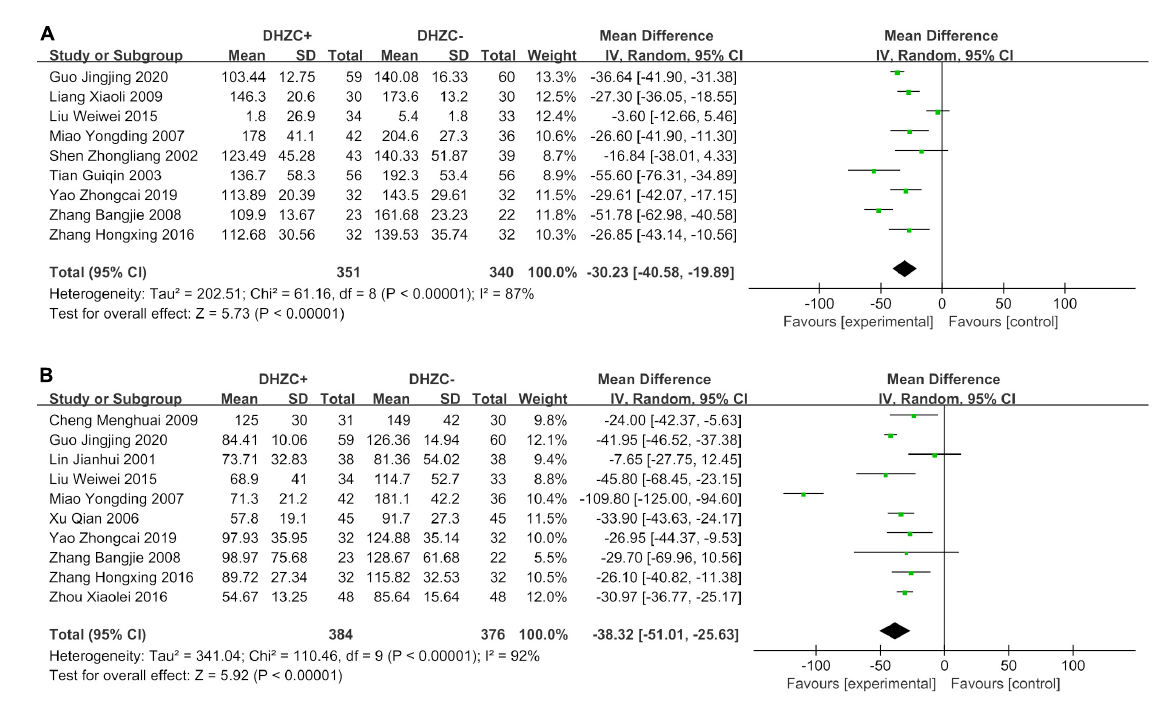
FIGURE4 The effect of Dahuang Zhechong pill (DHZCP)-based therapy on procollagen III (PCIII) and IV collagen (IVC). Random-effects models were applied. (A) Total PCIII; (B) Total IVC.